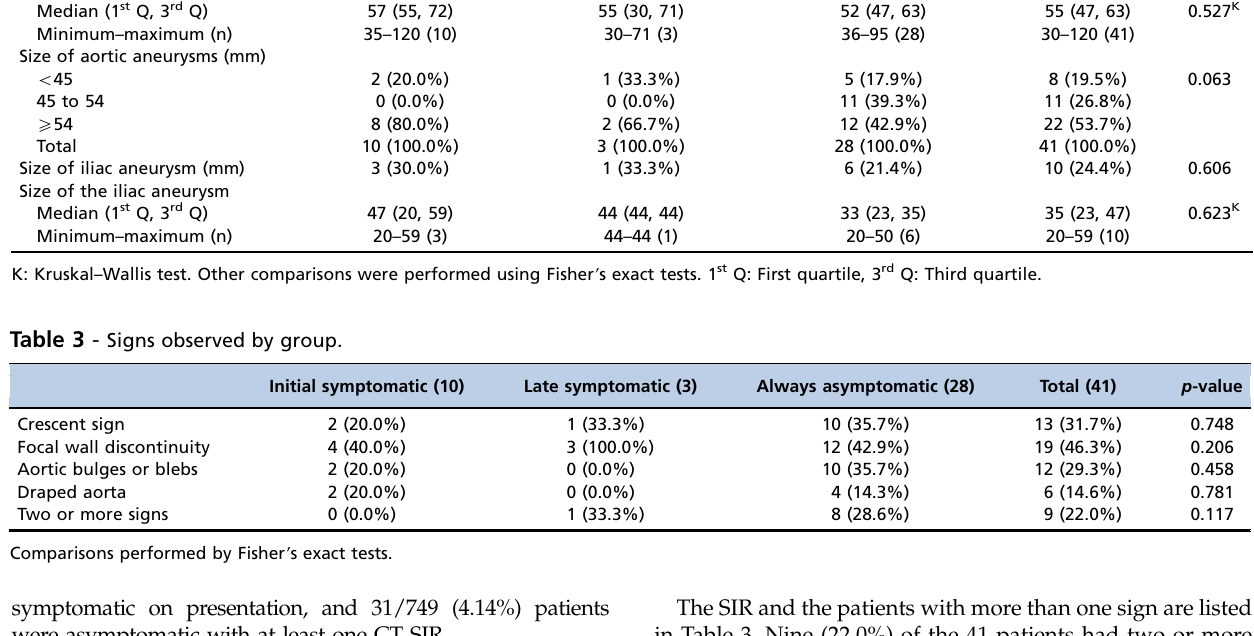
Table 2. Group comparisons for clinical characteristics and SIR- Focal wall discontinuity of circumferential calcifications was the most common CT imaging SIR, and was present in 19 patients (46.3%). There was no statistically significant differ- ence in the prevalence of SIR between the three groups.